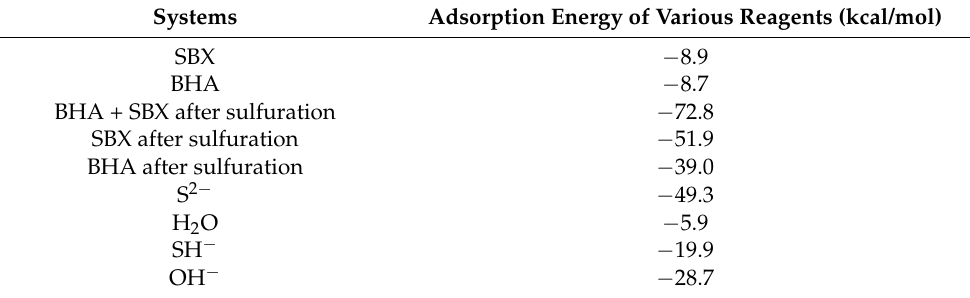
Table 3. Adsorption energies of adsorbates on the surface of